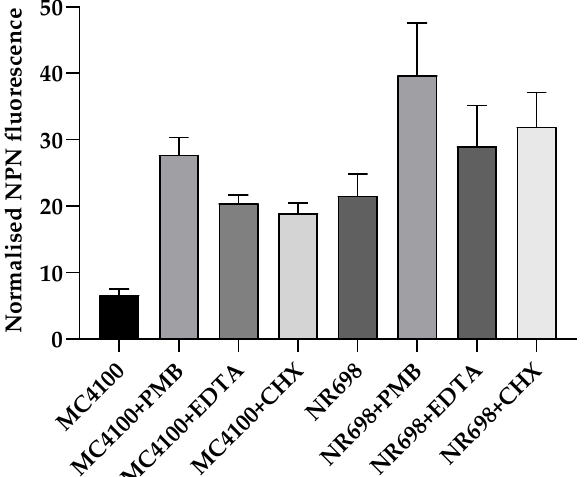
Figure 4. Relative NPN fluorescence in response to different membrane- and OM-active compounds. The permeability of the OM was assessed by measuring the fluorescence of NPN in both E. coli strains (MC4100 and NR698) after 2 min in the presence of 10 µ g/mL PMB, 5 mM EDTA, or 100 µ g/mL chlorhexidine (CHX). The fluorescence emission was plotted after normalizing all the samples to the bacteria in 5 mM HEPES buffer.